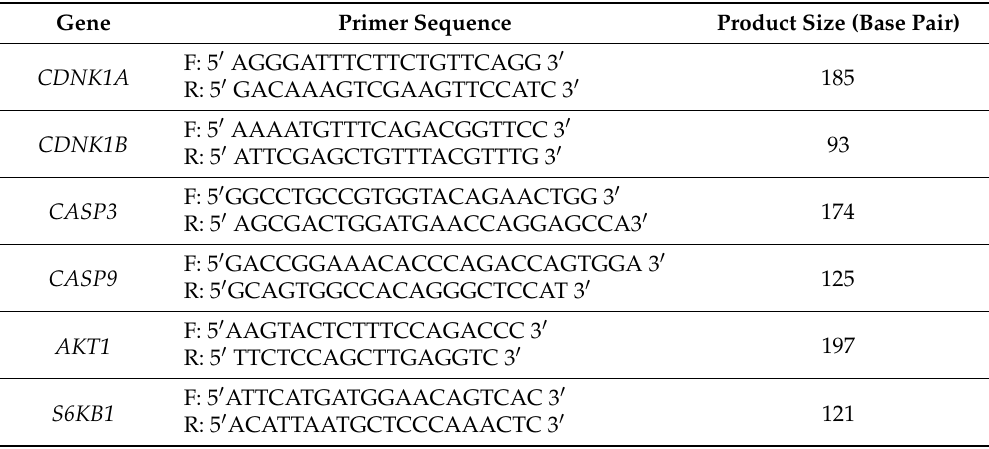
Table 1. Characteristics of the primers used in the